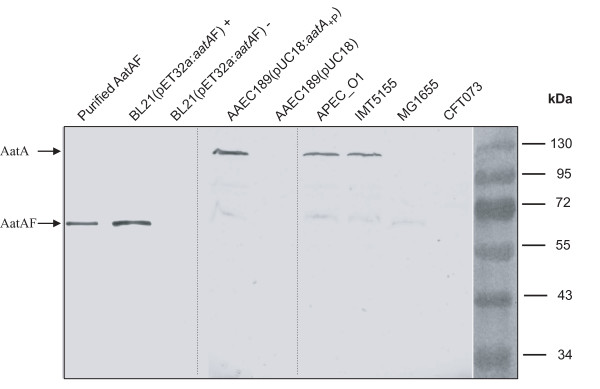
Expression of AatA in different E. coli strains. The purified fusion protein (lane 1) and total protein extract of BL21(pET32a:aatAF) (lanes 2 and 3), expressing AatAF under the control of the IPTG-inducible promoter, AAEC189(pUC18:aatA+P) expressing aatA under the control of the native promoter and AAEC189(pUC18) (lanes 4 and 5), APEC_O1 (lane 6), IMT5155 (lane7), CFT073 (lane 8) and MG1655 (lane 9) were separated on an SDS gel and blotted to polyvinylidene fluoride membrane. The membrane was then incubated with anti-AatA antibody.